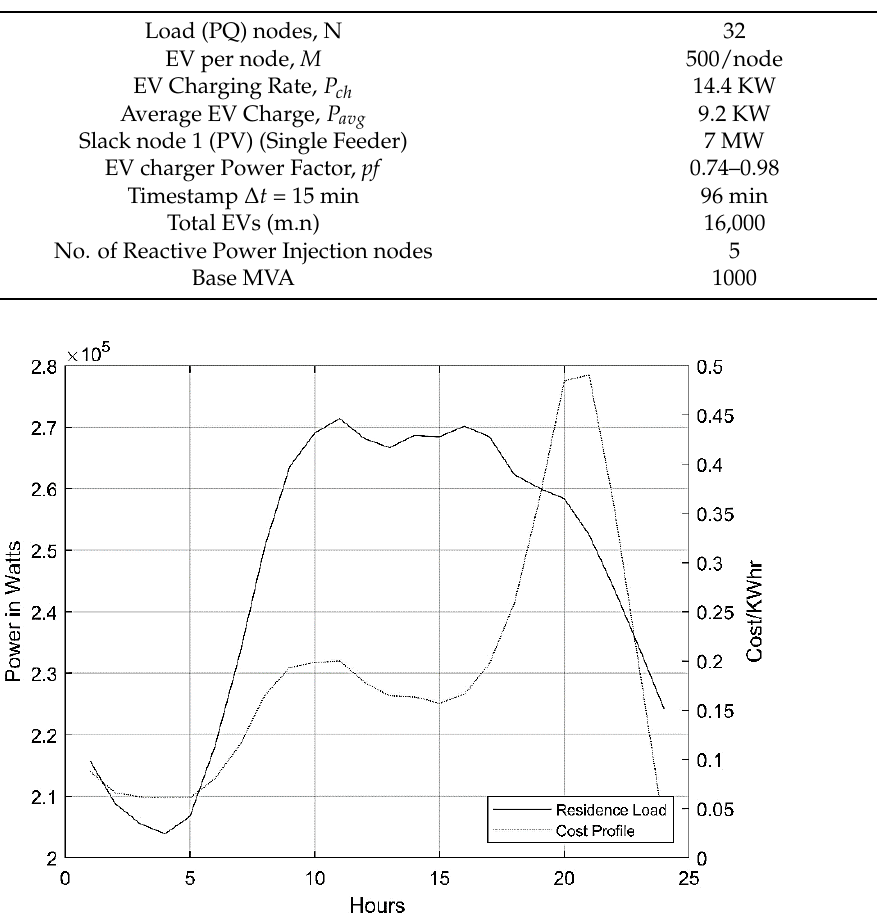
Table 1. Network and EV Parameters.